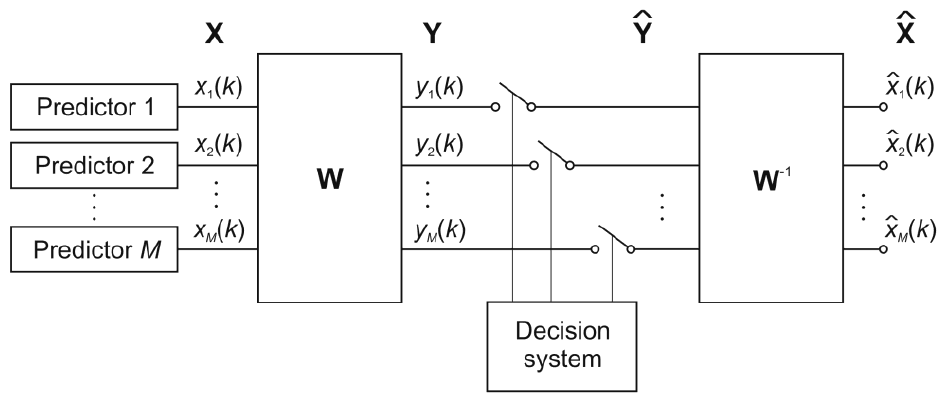
Figure 5. The illustration of ICA in the integration process of the ensemble of predictors [15]. The time series predicted by M predictors are separated into independent components using ICA represented here by the matrix W . The switches are used to eliminate the inappropriate independent components in the reconstruction stage of the data. The passed components are used to reconstruct the noise-free prognosis through matrix W −1 (so-called deflation process).